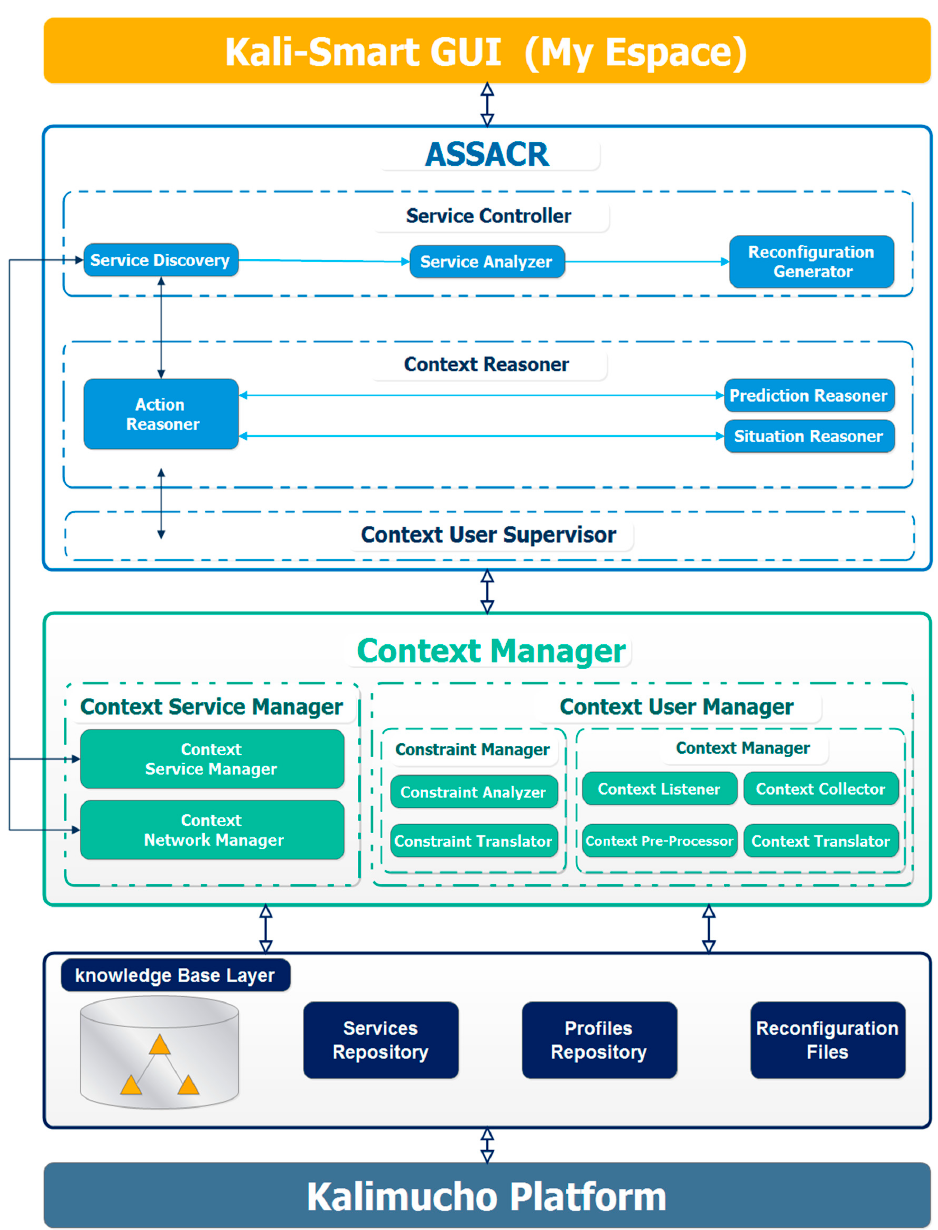
Figure 1. Kali ‐ Smart: platform architecture. ASSACR (Autonomic Semantic Service Adaptation Figure 1. Kali-Smart: platform architecture. ASSACR (Autonomic Semantic Service Adaptation Controller and Reconfiguration). Controller and